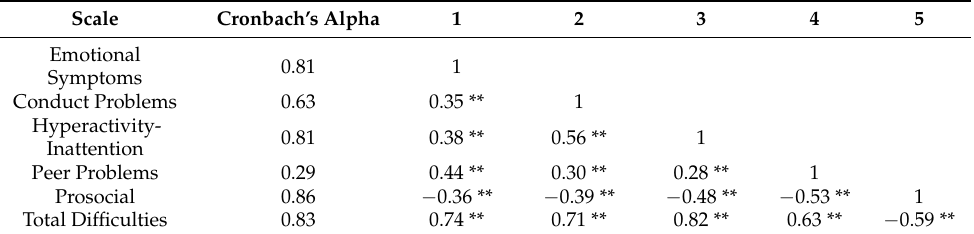
Table 3. Internal Reliability.